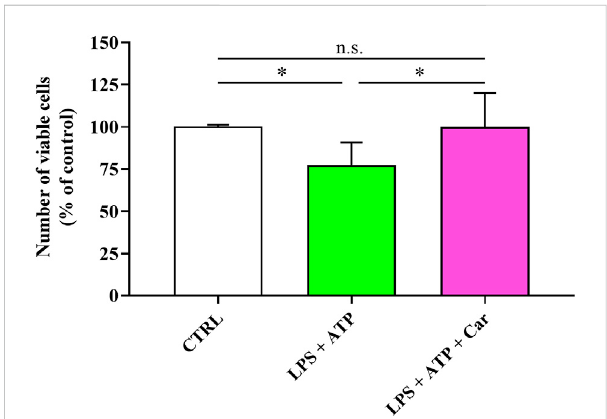
FIGURE 1 Number of viable cells in resting HMC3 and in HMC3 cells stimulated with LPS (100 ng/mL, 24 h) + ATP (5 mM, 30 min), in the absence or presence of carnosine (Car) (10 mM, 1 h pre-treatment). The number of viable cells is expressed as the percent variation with respect to the untreated (CTRL) cells. Values are means ± SD of four to fi ve different cell counts. Standard deviations are represented by vertical bars. *signi fi cantly different, p <